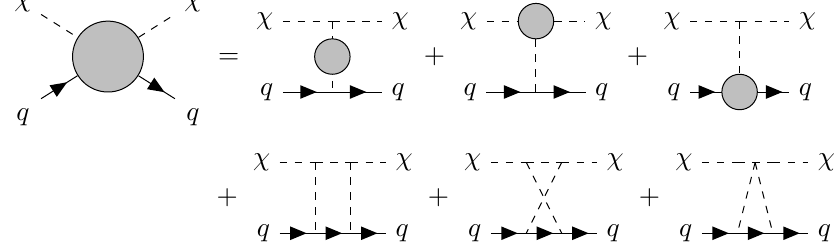
Figure 2 . One-loop EW corrections to DM-quark scattering. They are given by propagator corrections, vertex corrections, box and triangle